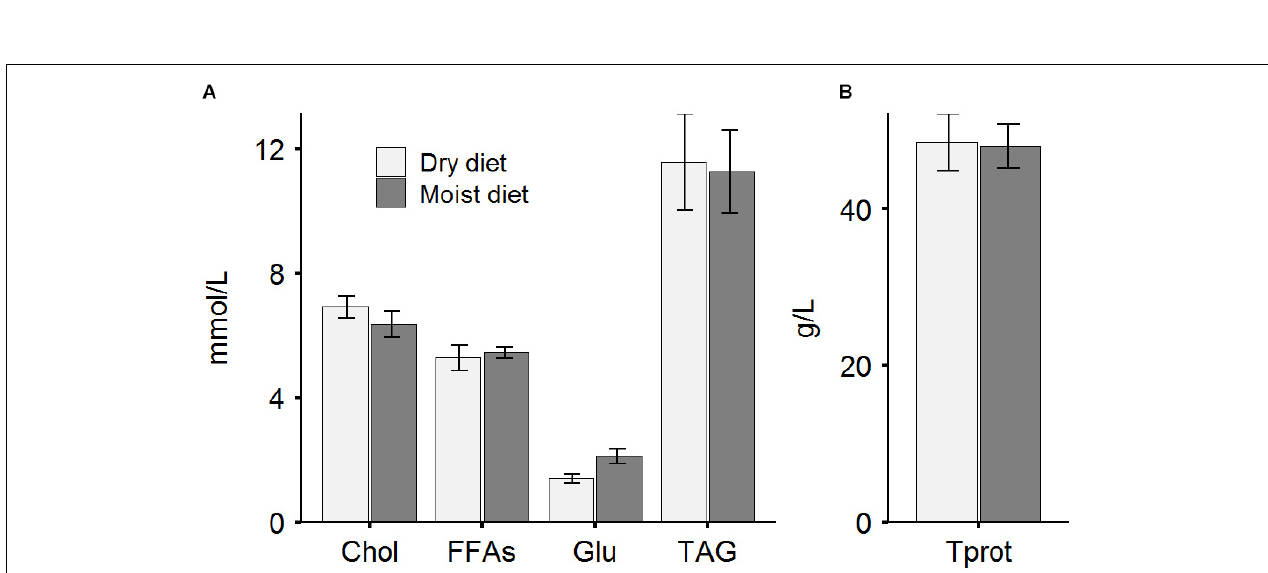
FIGURE 8 | Apparent digestibility coefficient (ADC) of lipid in ballan wrasse intestine. The figures show ADC (%) of lipid (total fatty acids), TFA; monounsaturated fatty acids, MUFA; polyunsaturated fatty acids, PUFA; and saturated fatty acids, SFA in the 4 intestinal segments (S1–S4) of ballan wrasse fed dry or moist diets. Asterisk’s ( ∗ ) above gray horizontal square bracket indicate significant differences between adjacent segments (glmmPQL test in R). ∗∗∗ p < 0.001, ∗∗ p < 0.01, ∗ p < 0.05. No significant differences occurred in fatty acid ADCs within intestinal segments between fish fed dry and moist diets. Data are mean ± SEM, n = 6.